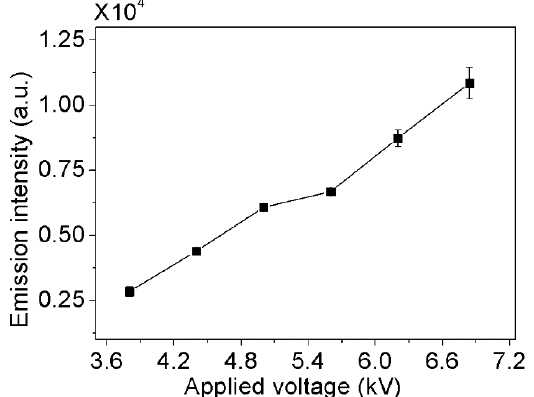
Figure 7. The effect of the applied voltage on emission intensity (Ar flow rate: 2.1 L/min, no organic matter and nitric acid added).